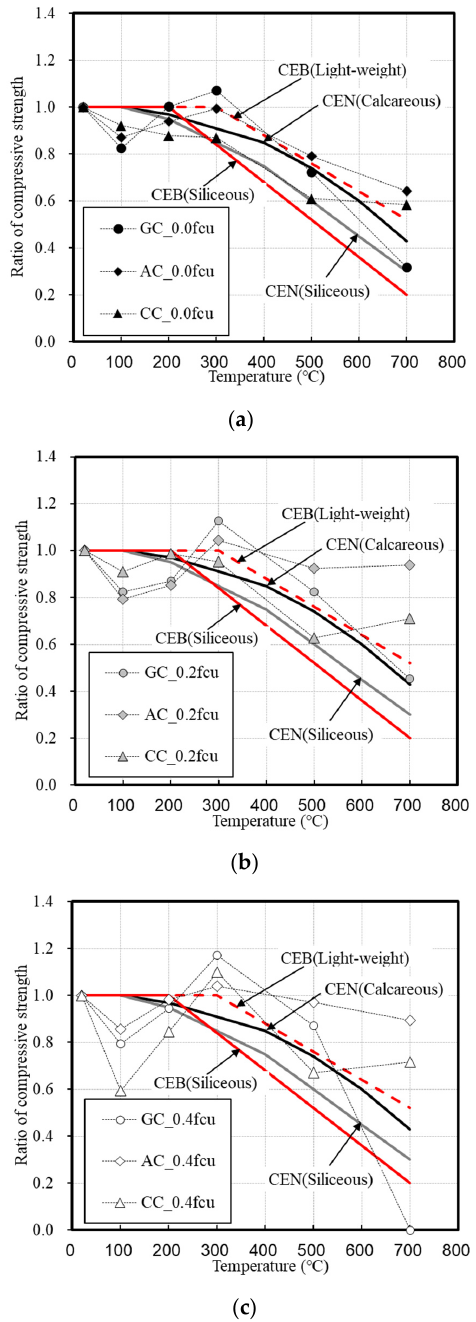
Figure 8. Comparison of experimental data with CEN and CEB codes on compressive strength. ( a ) 0.0fcu loaded. ( b ) 0.2fcu loaded. ( c ) 0.4fcu loaded.